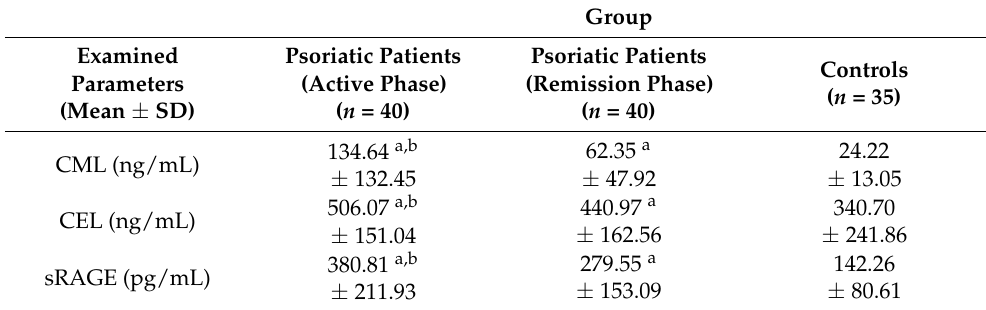
Table 2. Concentrations of CML, CEL, and sRAGE in sera samples of the patients and healthy controls.